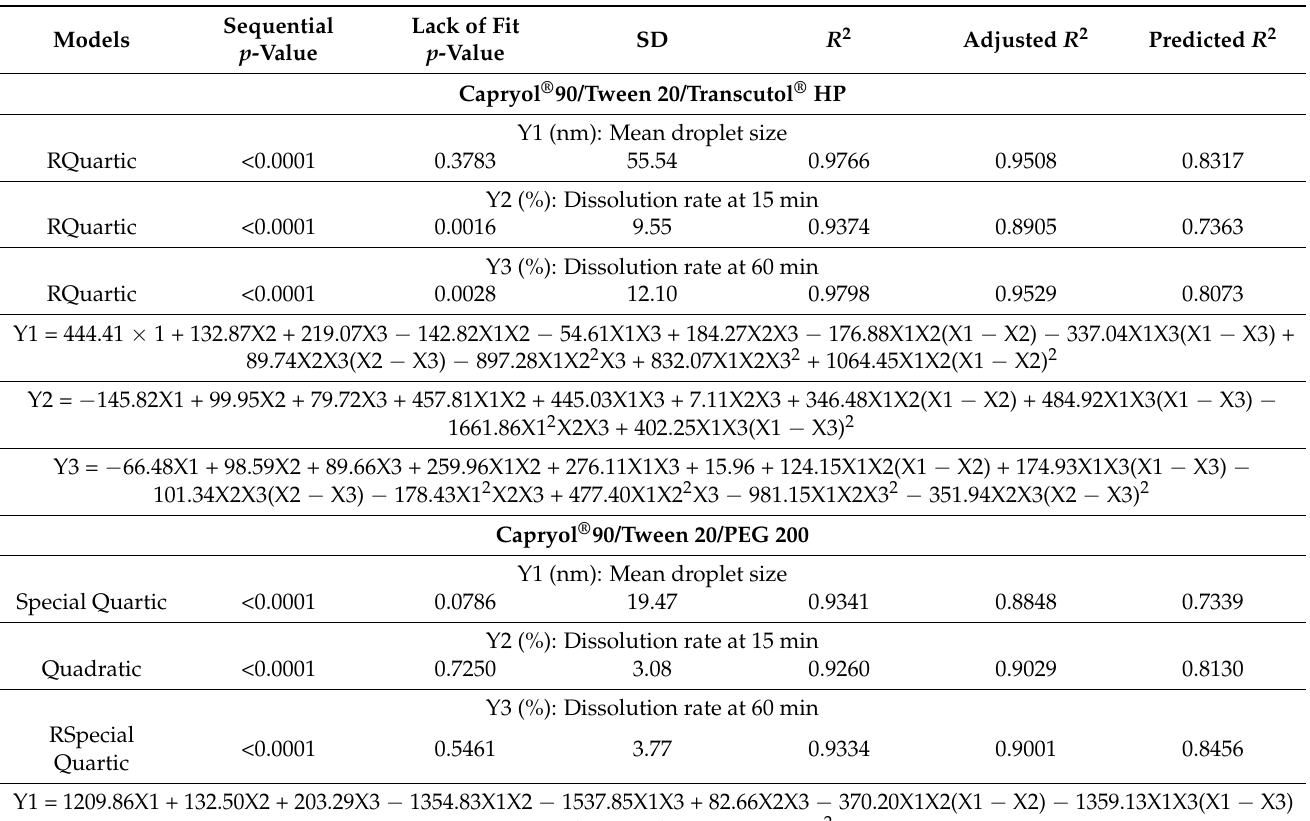
Table 3. Summary of the results of statistical analysis and model equations for measured response for D-optimal mixture design.